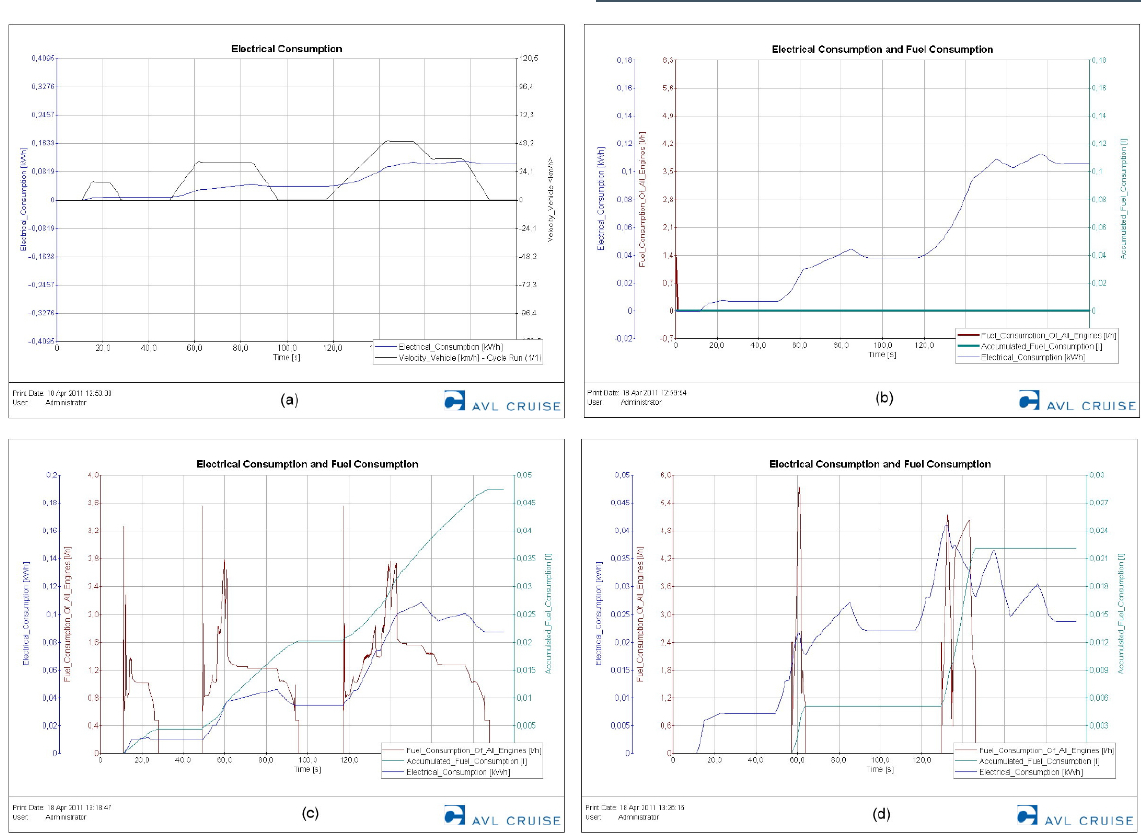
Figure 8. The fuel and/or electrical consumption in respect of: Electric vehicle (a), Electric vehicle with range extender (b), Hybrid vehicle with CVT (c), Hybrid vehicle with planetary gearbox (d).